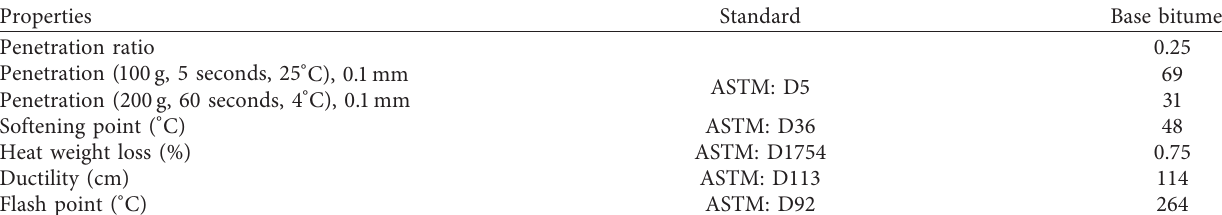
Table 2: The features of the base